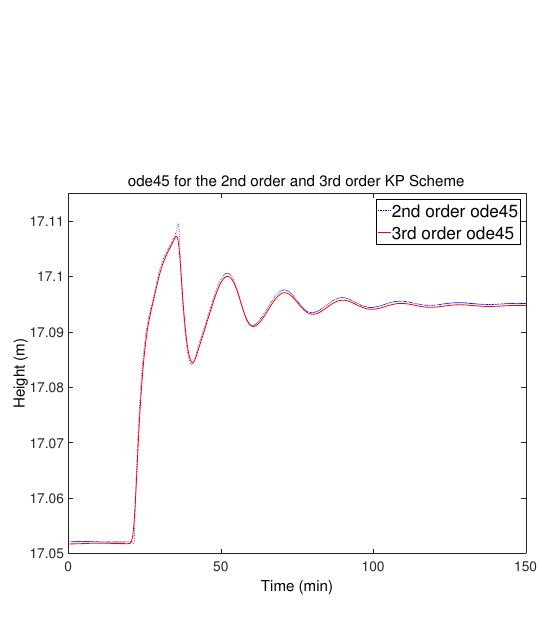
Figure 12: ode45 for 2 nd and 3 rd order KP scheme.